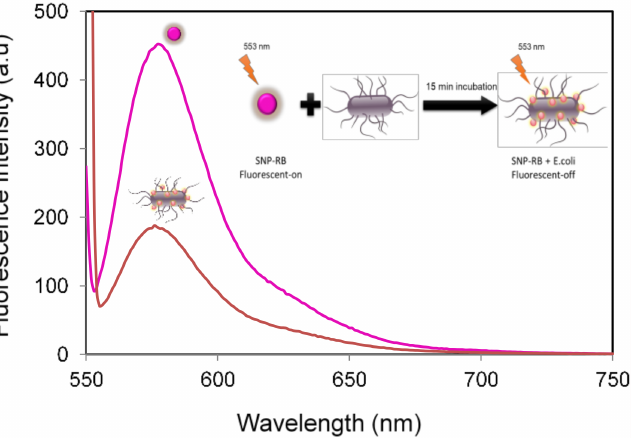
Figure 3. The fluorescence emission spectra of SNP-RB in deionized water (pink) and SNP-RB in the presence of E. coli proteins (orange). Concentration of SNP-RB and E. coli was 1 mg/mL and 1 × 10 7 CFU/mL,